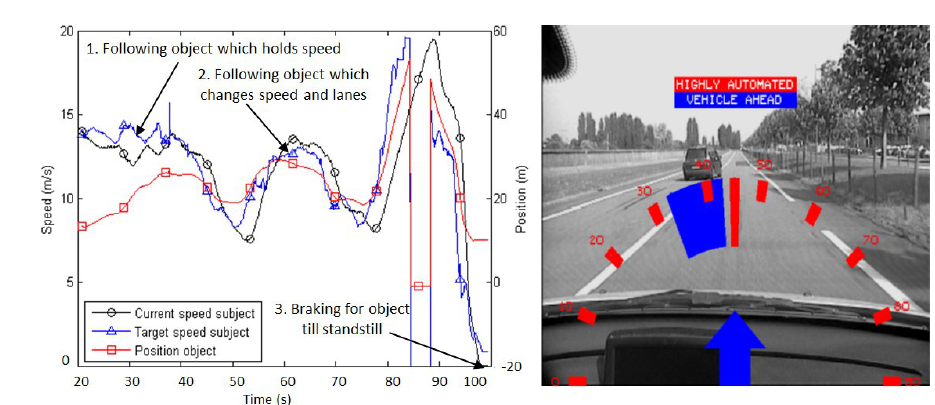
Figure 15. “Following target” scenario, with a change in speed and lane.